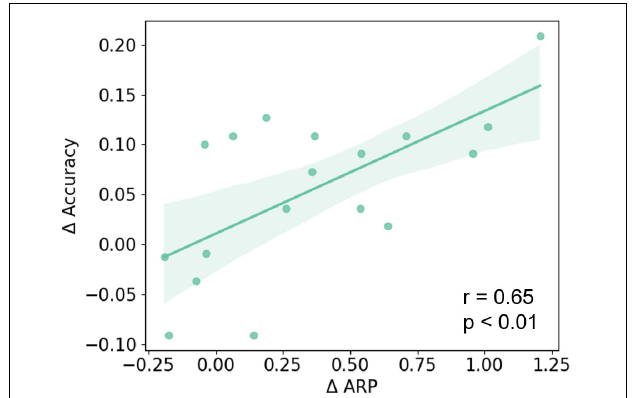
FIGURE 6 | The Pearson correlation between (cid:49) ARP and changes of MI-BCI performance ( (cid:49) Accuracy). A significant positive correlation was found between the (cid:49) ARP and (cid:49) Accuracy of the three-class classification ( r = 0.65; p < 0.01).